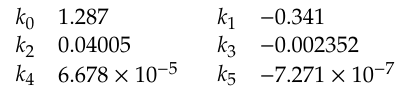
Table 5. Coe ffi cients of Equation (11).